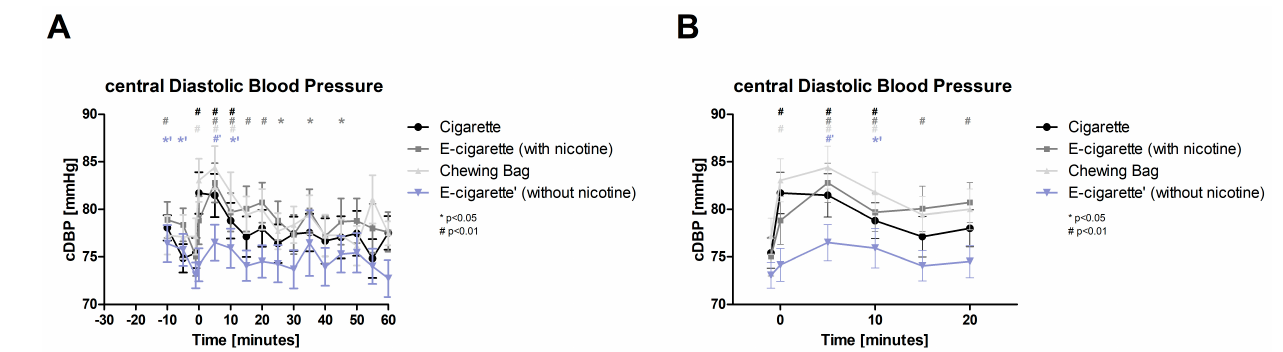
Figure 4. Central systolic blood pressure ( A ) total follow up; ( B ) follow up of expected nicotine half-